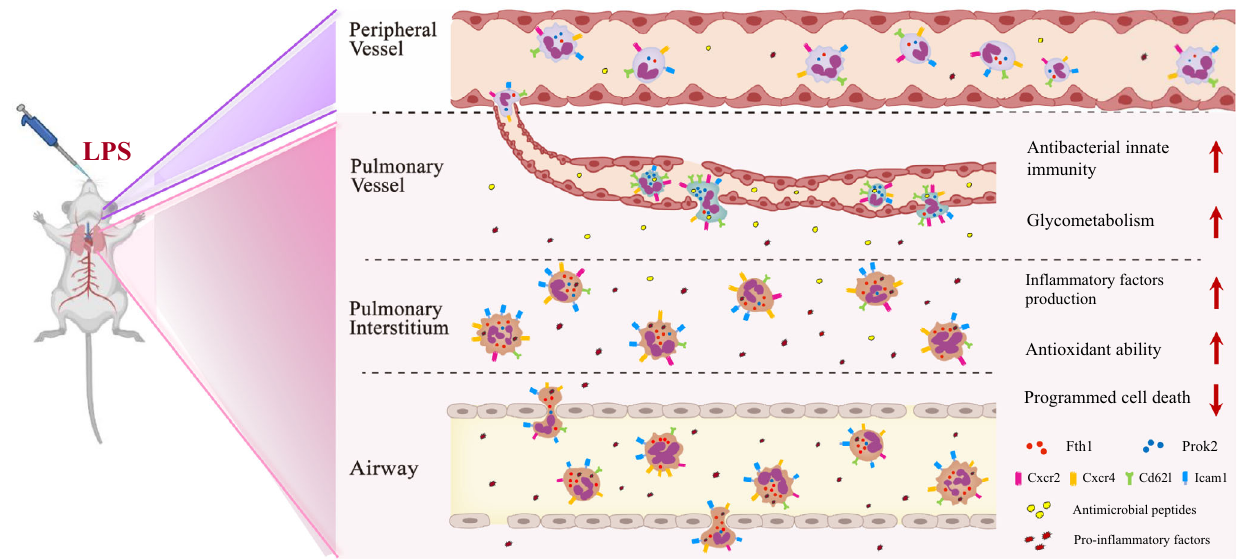
Fig. 10 | Proposed mechanisms of two neutrophil subsets in lung tissue of ALI mice. When neutrophils migrate from systemic circulation to the pulmonary vasculature in ALI mice, the effect of mechanical deformation and the char- acteristics ofthemicroenvironmentmakethemmoreadaptivetodefenseagainst pathogens (Prok2 hi Neu). During subsequent trans-endothelial and